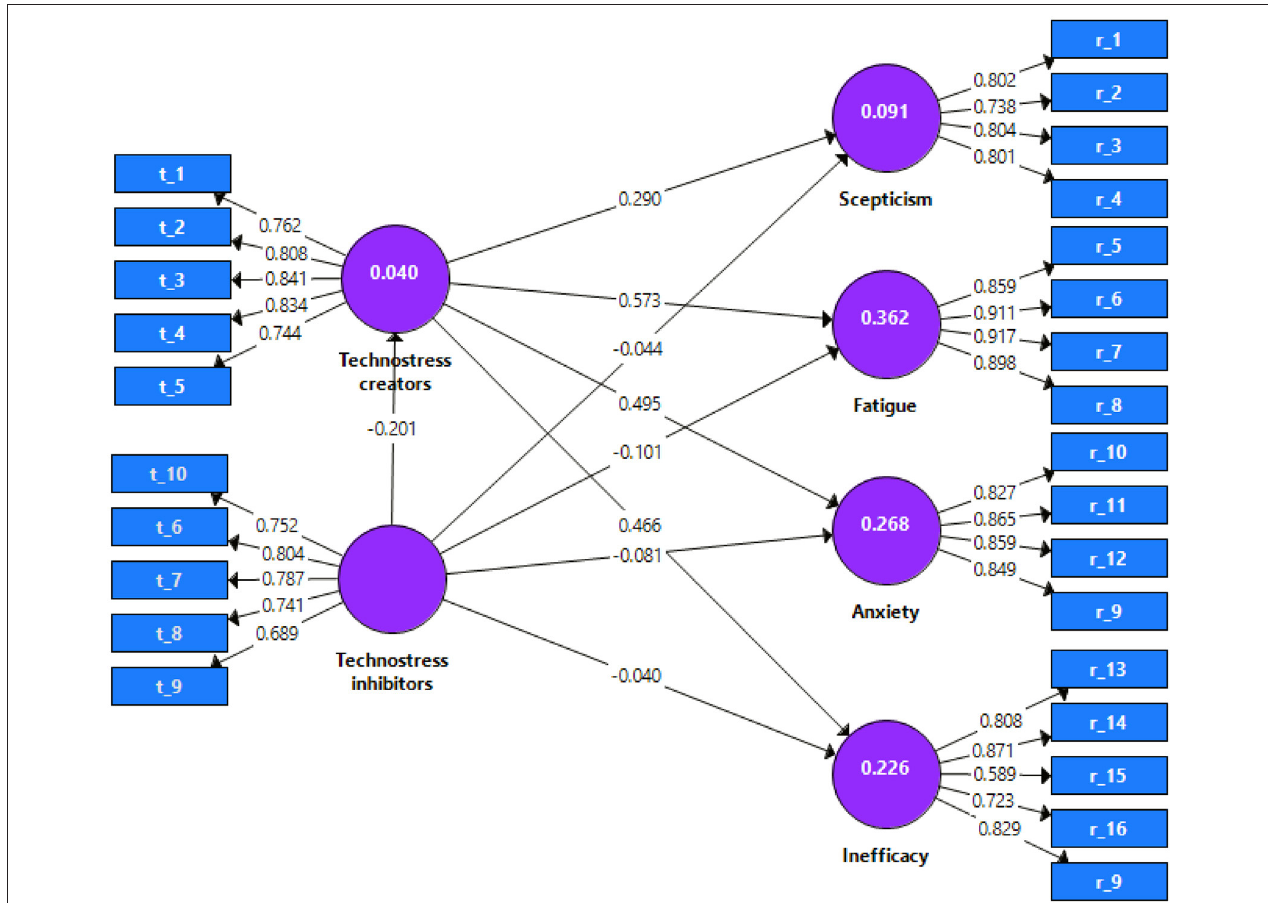
FIGURE 2 | Structural model evaluation